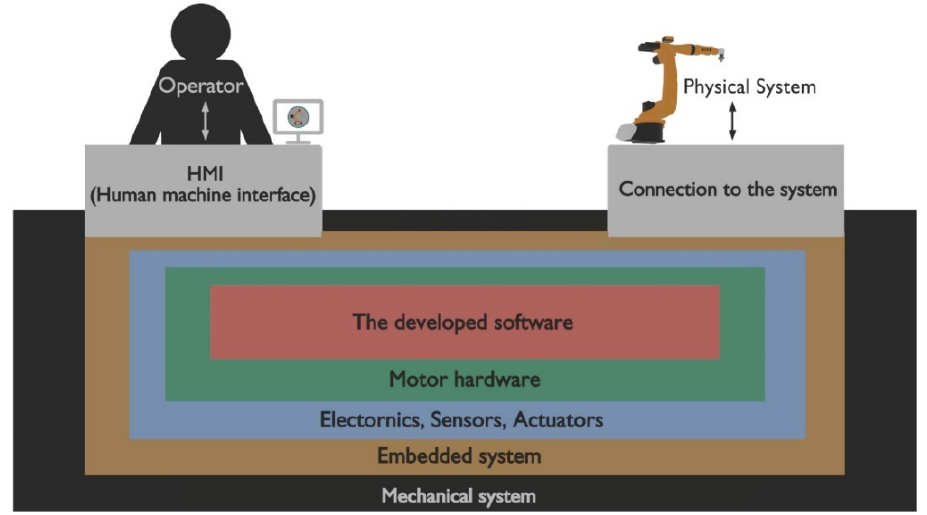
Figure 2. Architecture model of CPS.